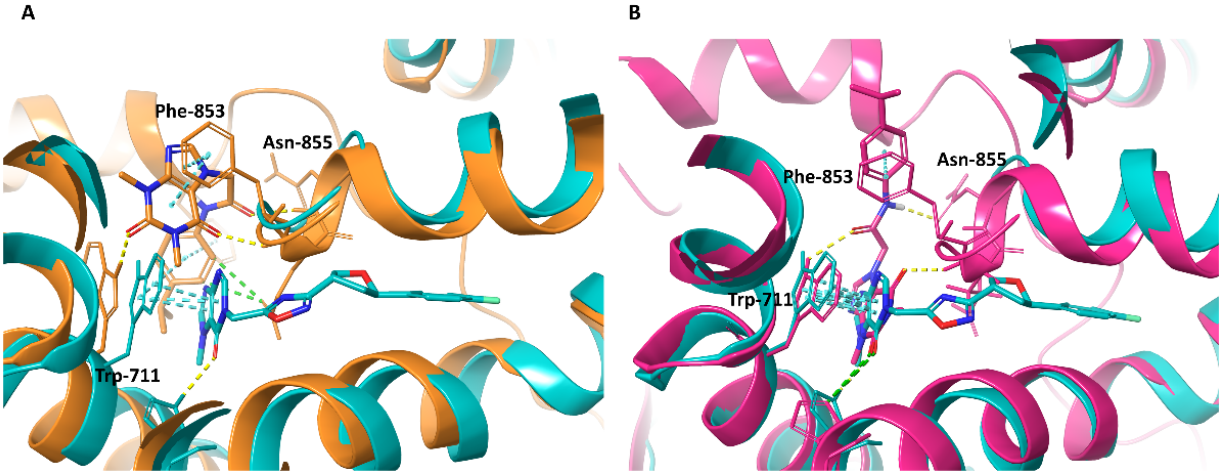
Figure 8. Binding modes of HC-030031 (predicted) and compound 21 (experimental) in the TRPA1 ion channel: ( A )—complex C (orange) aligned with 7JUP (cyan); ( B )—complex G (pink) aligned with 7JUP (cyan), with visible similarity of the binding interactions.